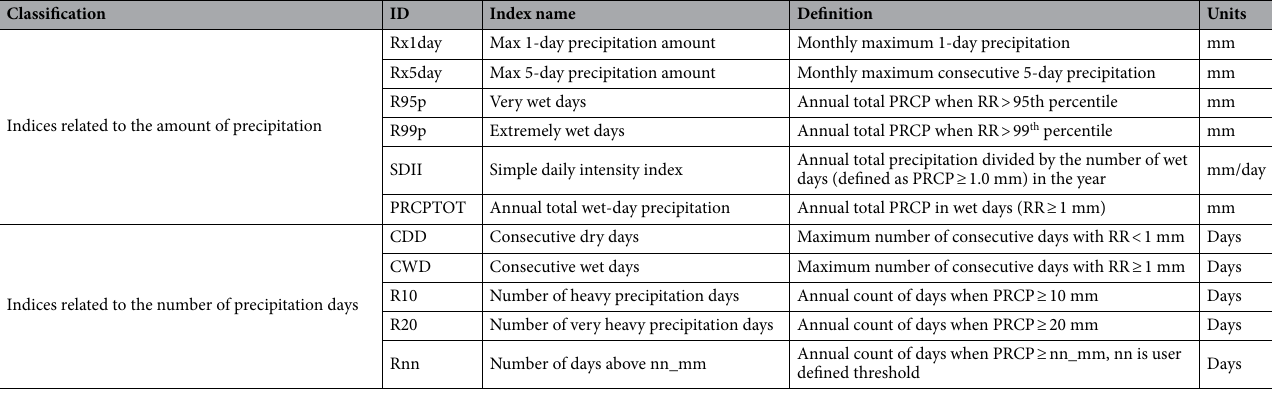
Table 1. List of climate extreme indices for precipitation used in this